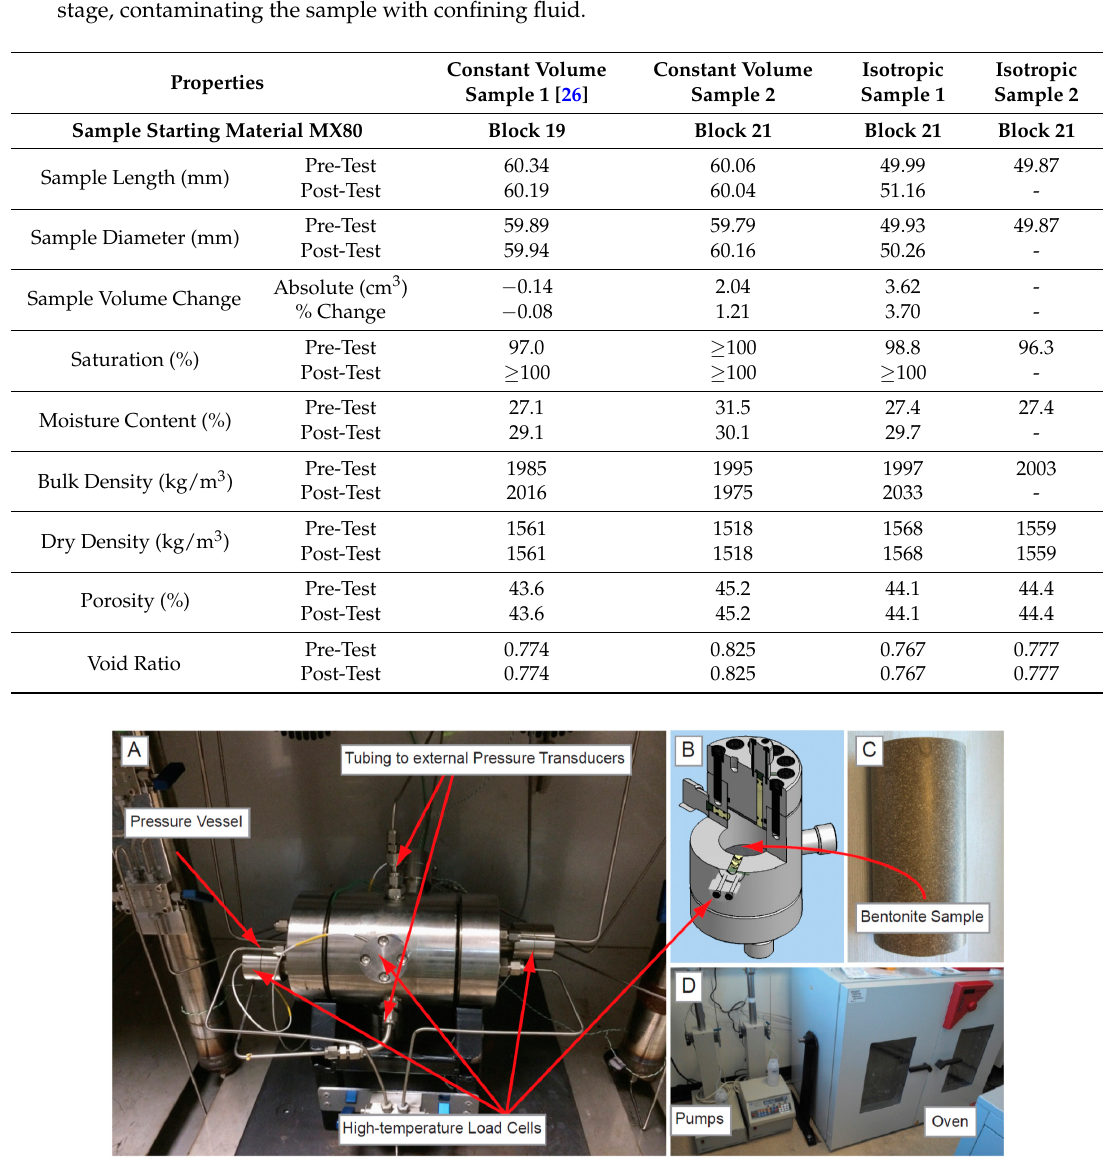
Figure 1. ( A ) Experimental apparatus for the second constant volume radial flow (CVRF-2) test; ( B ) Cross section through the pressure vessel; ( C ) Bentonite sample; ( D ) Injection and backpressure pumps and the oven containing the experiment.